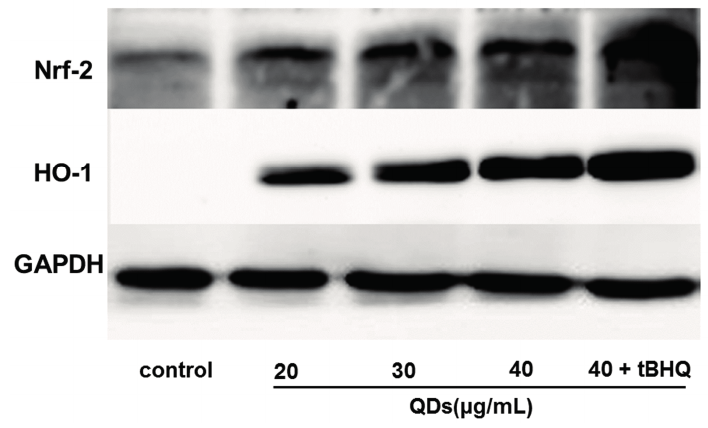
Figure 7. The protein expression level of Nrf2 and HO-1 in the total cellular protein extract or the nuclear extract of AML12 cells. AML12 cells were exposed to 20, 30, 40 µg/mL CdTe QDs and (40 µg/mL CdTe QDs + tBHQ) for 24 h. The protein expression of HO-1 was measured in the total cell lysates; whereas Nrf2 was measured in the nuclear